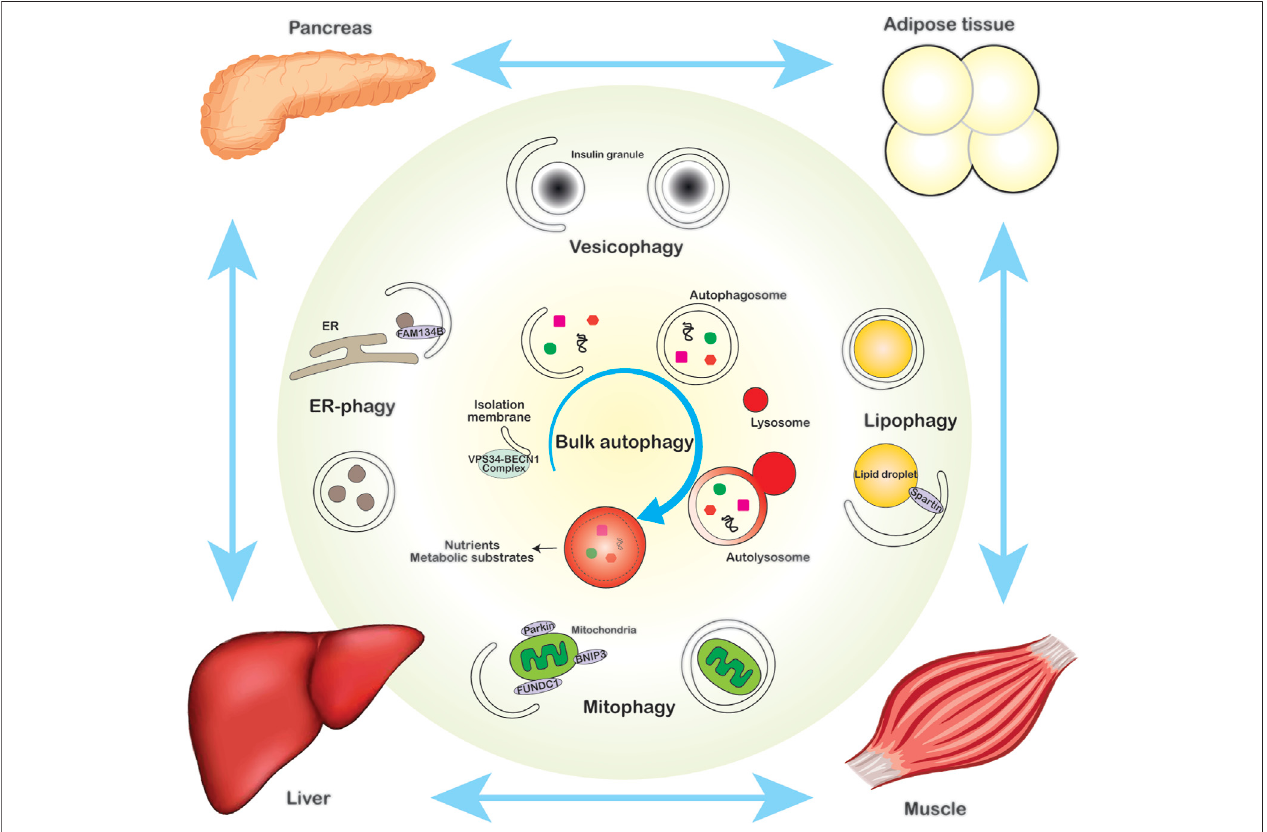
FIGURE 1 | The role of autophagy in intracellular and systemic energy homeostasis. Bulk autophagy (center) and organelle-speci fi c selective autophagy, such as vesicophagy(top),ER-phagy (left),lipophagy (right)and mitophagy (bottom), playpivotalrolesinmaintainingintracellular energy homeostasisviasupplyingnutrientsand